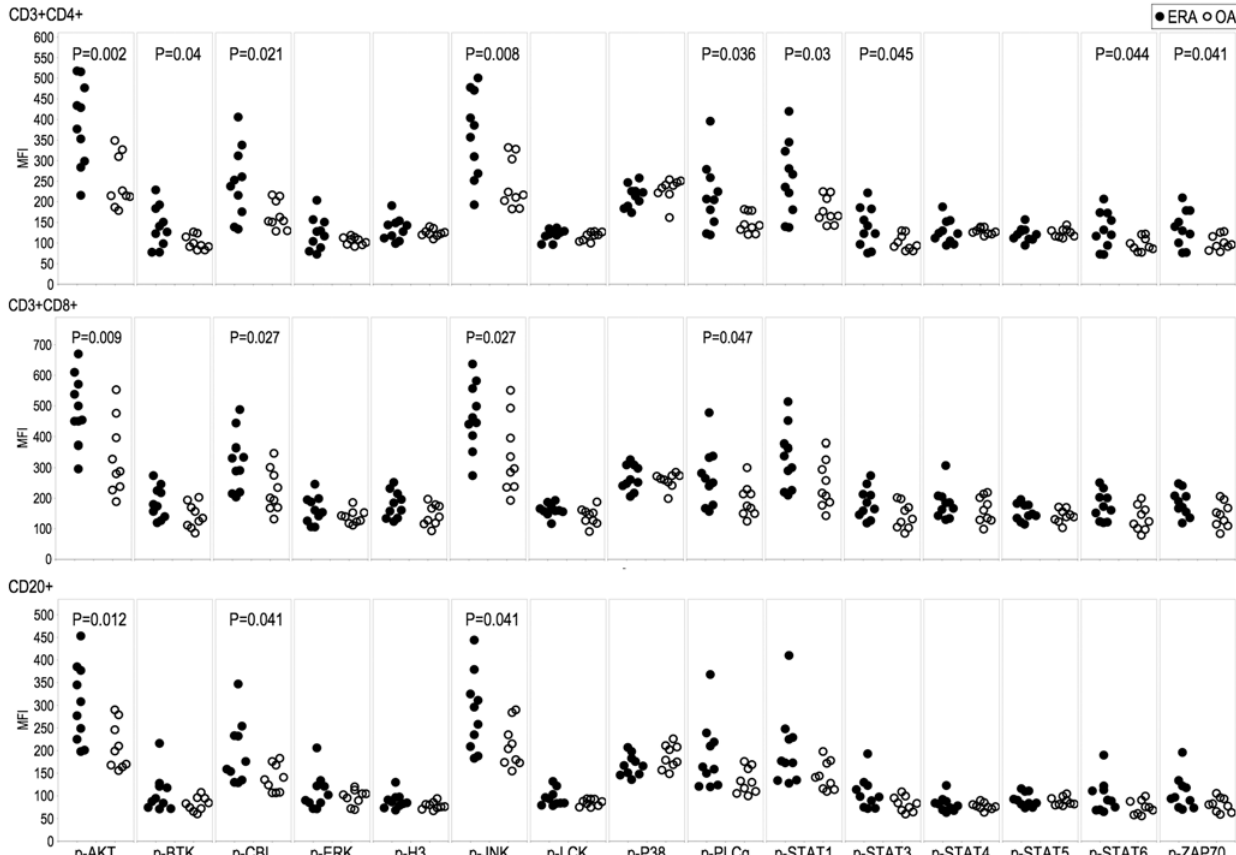
Figure 3. Distinct phosphorylation signatures between ERA and OA PBMCs. PBMCs from patients with ERA (n=10, closed circles) and OA (n=9, open circles) were analyzed by multiparameter phospho-FACS, gating on CD3 + CD4 + , CD3 + CD8 + and CD20 + cell populations, as indicated. Scatterplots of the MFI for 15 phospho-specific epitopes are shown. Significant differences were calculated by Student’s t test (p , 0.05).